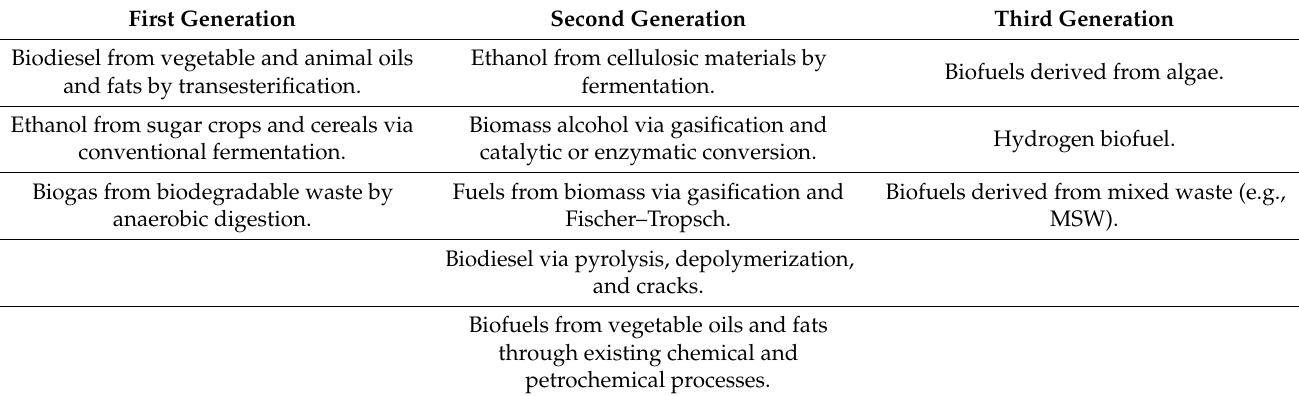
Table 2. Relationship of raw material, technology, and types of biofuels produced (adapted from [17]). First Generation Second Generation Third Generation Biodiesel from vegetable and animal oils Ethanol from cellulosic materials by Biofuels derived from algae. and fats by transesterification. fermentation. Ethanol from sugar crops and cereals via Biomass alcohol via gasification and conventional fermentation. catalytic or enzymatic conversion. Biogas from biodegradable waste by